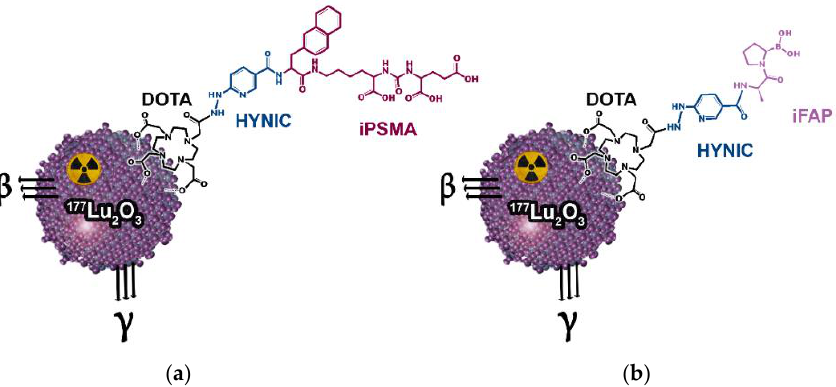
Figure 1. Schemes of the ( a ) 177 Lu 2 O 3- iPSMA and ( b ) 177 Lu 2 O 3- iFAP nanosystems. As expected, the biodistribution profile of 177 Lu 2 O 3 -iPSMA and 177 Lu 2 O 3 -iFAP, after intravenous injection into healthy CD1 mice, indicated a considerable hepatic uptake for both nanosystems, without significant differences between them ( p < 0.05) (Tables 1 and 2). The second and third target organ was the spleen and lung, with approximately 15